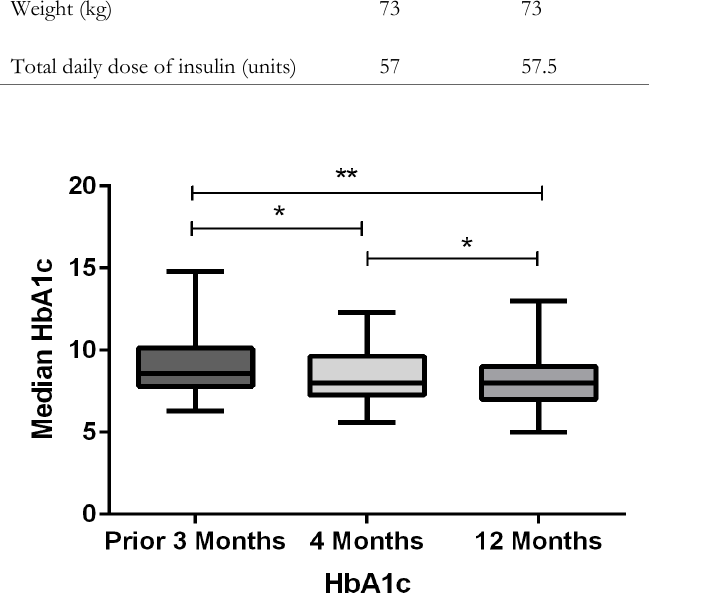
Figure 1: Median HbA1c with duration of CSII